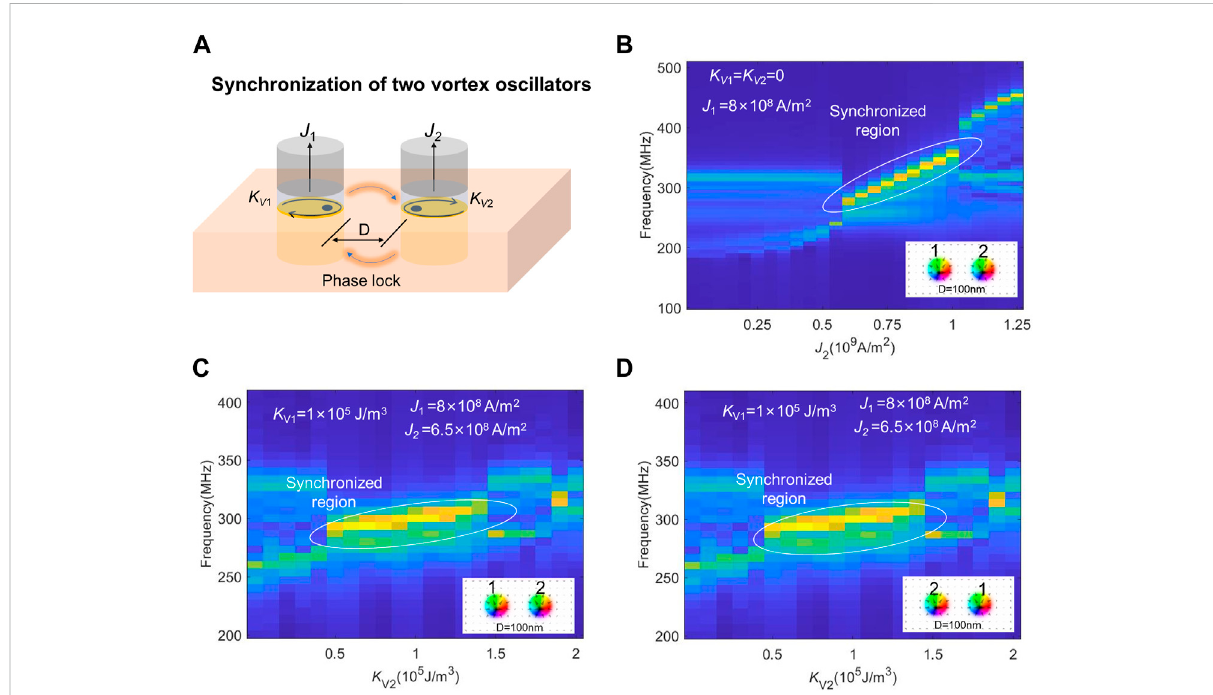
FIGURE 3 (A) Schematicillustrationforthesynchronizationoftwonon-identicalvortexnano-oscillatorswithvaryingspinpolarisedcurrentdensity( J )and anisotropy constant of the vortex region ( K V ). (B) Synchronization frequency spectra for two oscillators separated by a distance of 100 nm with varying J when the K V for both oscillators are 0. The injected current density for oscillator 1 ( J 1 ) is fi xed at 8 × 10 8 A/m 2 while that of oscillator 2 ( J 2 ) is varied. (C) Synchronization frequency spectra for two oscillators separated by a distance of 100 nm with varying K V when the J for both oscillators are fi xed at 8 × 10 8 A/m 2 . The anisotropy constant of the vortex region for oscillator 1 ( K V1 ) is fi xed at 1 × 10 5 J/m 3 while that of oscillator 2 ( K V2 ) is varied. (D) Synchronization frequency spectra when oscillator one and two switch their